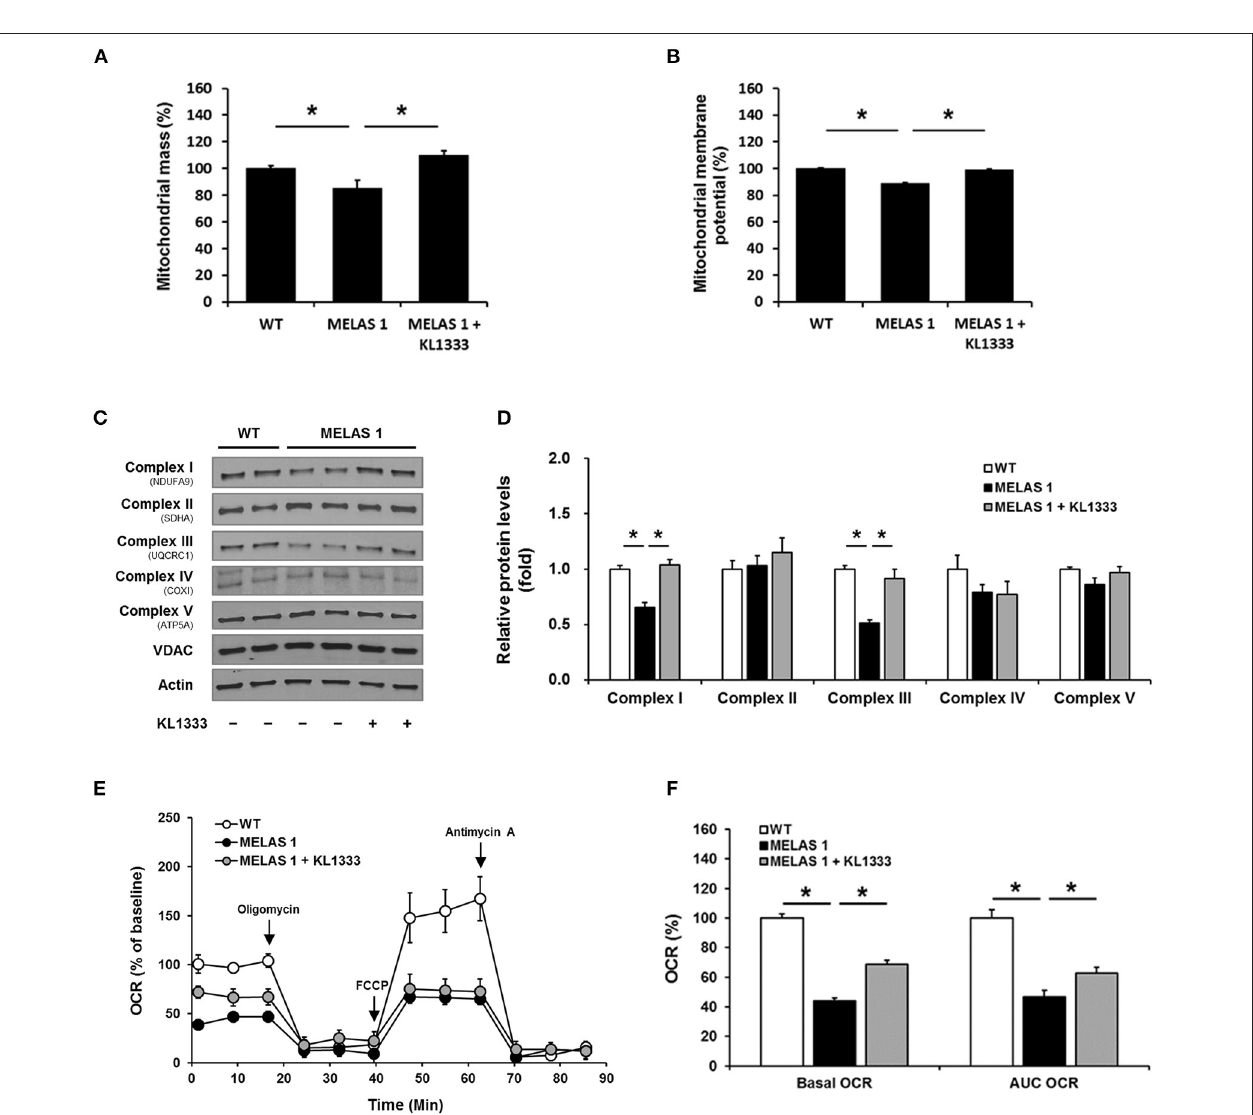
FIGURE 7 | KL1333 improves mitochondrial mass and OXPHOS in MELAS fibroblasts. MELAS 1 fibroblasts were treated with 1 µ M KL1333 for 24h. (A) Cells were stained with MitoTracker Green FM, and mitochondrial mass was measured using a flow cytometer. (B) Cells were stained with TMRM, and mitochondrial membrane potential was measured using a flow cytometer. (C) Protein levels of mitochondrial complex subunits were analyzed by Western blotting using the indicated antibodies. (D) Quantification of mitochondrial complex subunit proteins using their band densities normalized to that of VDAC. (E) MELAS 1 fibroblasts were treated with 1 µ M KL1333 for 24h, and OCR was measured using the Seahorse XF24 analyzer. Oligomycin, FCCP, and antimycin A were sequentially added at the indicated time points (arrow). (F) Basal OCR and AUC OCR are shown in the histogram. Each experiment was repeated three times. Error bars indicate ± SEM. * P < 0.05.